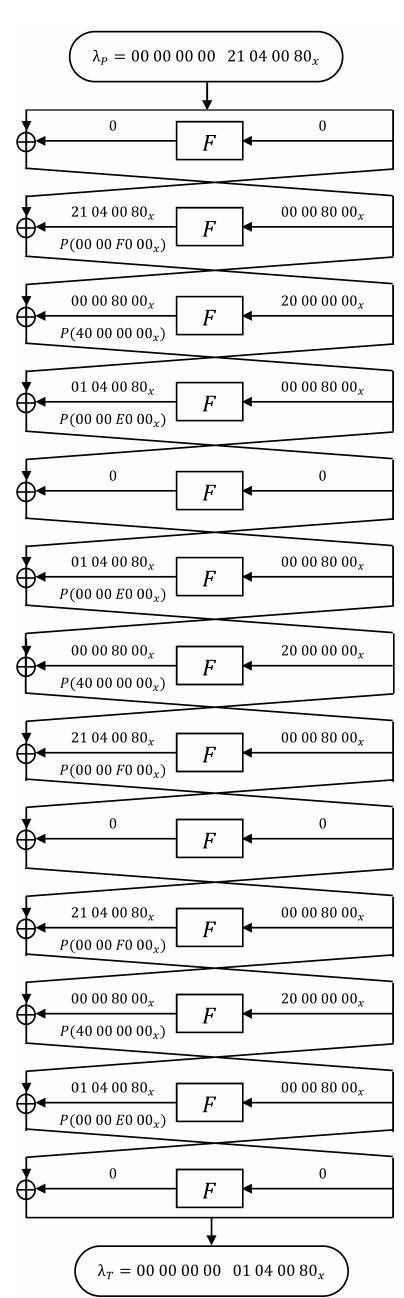
Figure 9: 13 Rounds of Matsui’s Linear Approximation ( λ 4